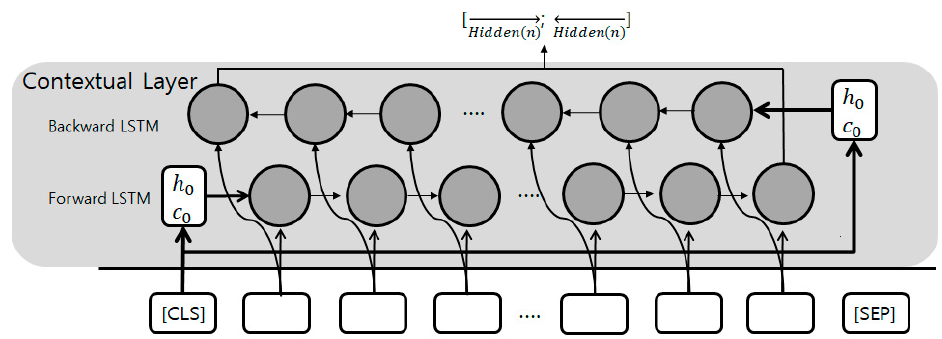
Figure 6. The contextual layer with hidden and cell states initialized to [CLS].